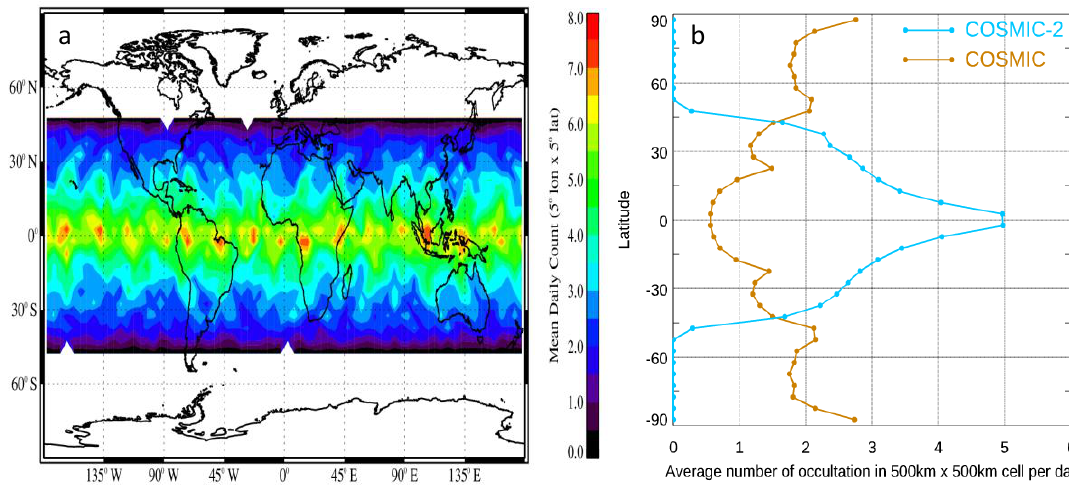
Figure 2. ( a ) The average of COSMIC-2 occultations in 500 × 500 km 2 box per day during October 2019. ( b ) The daily average of the COSMIC-2 (in blues line) and COSMIC (in red line) density distribution was constructed by 500 × 500 km 2 cells in the same latitude band. COSMIC data are from October 2009.